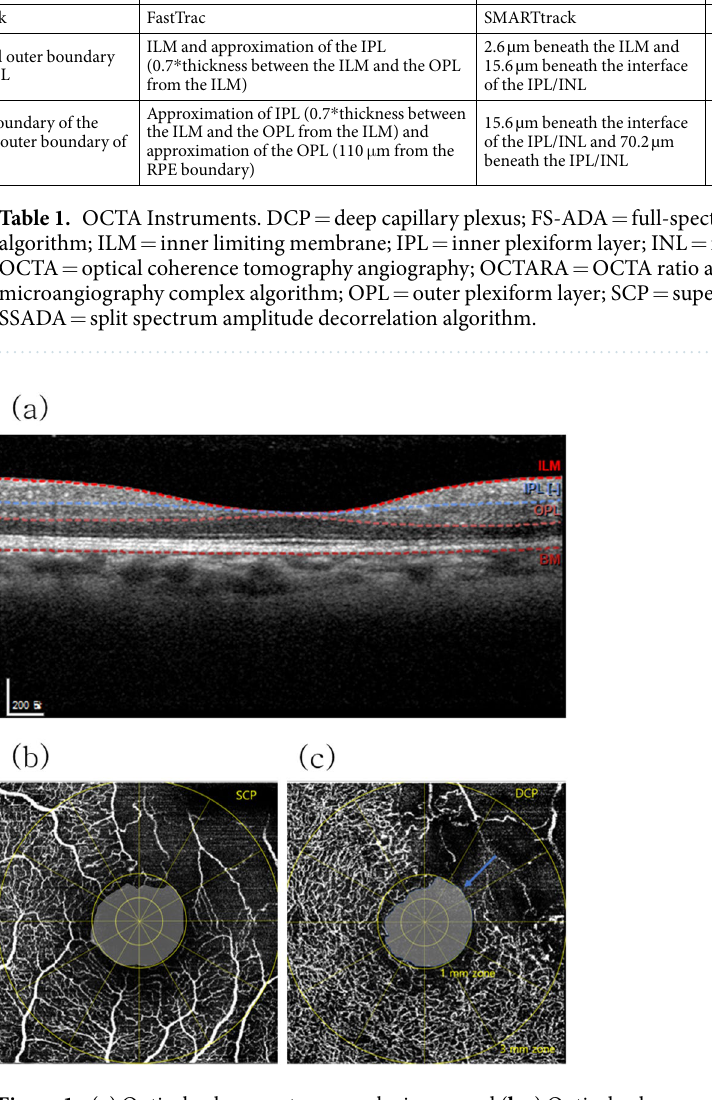
Figure 1. ( a ) Optical coherence tomography image and ( b , c ) Optical coherence tomography angiography (OCTA) images obtained using the Spectralis OCTA device (Heidelberg Engineering, Heidelberg, Germany). ( b , c ) In this case, the superior border of the foveal avascular zone (FAZ) was vague due to vascular dropout (blue arrow). Nonperfusion area 1 (NPA1) of ( b ) the superficial capillary plexus (SCP) and ( c ) the deep